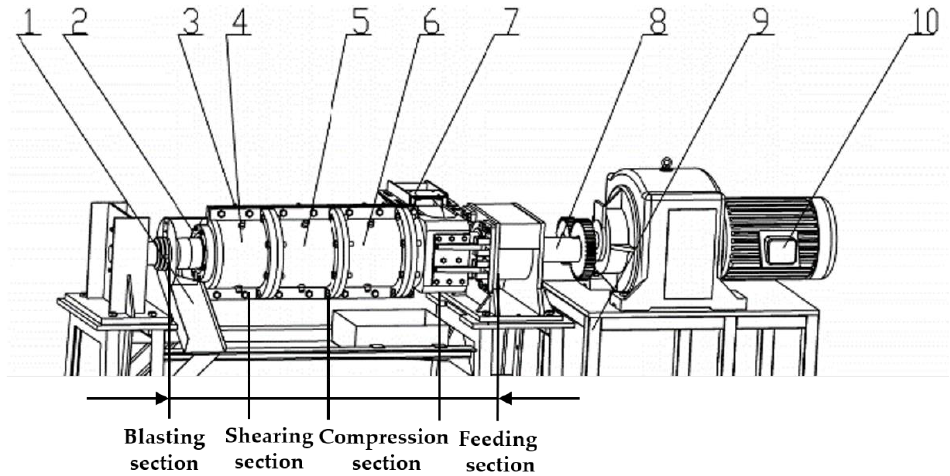
Figure 1. The structure of the D200 straw fiber making machine. 1. Discharge port; 2. Regulating die head; 3. Cooling system; 4. Blasting Section; 5. Shearing Section; 6. Compression Section; 7. Force-feeding device; 8. Spindle; 9. Frame; 10. Main motor.